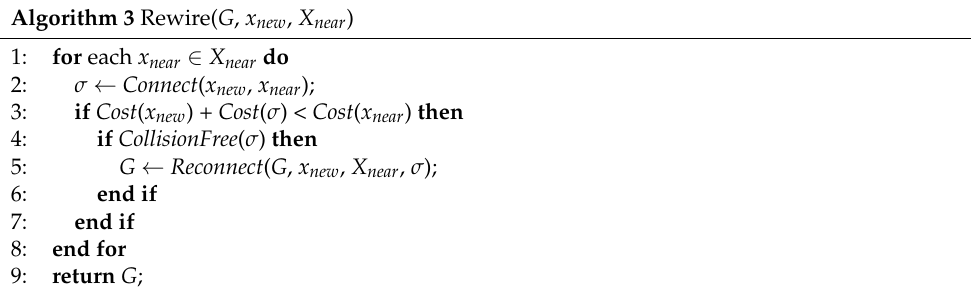
x new x new x nearest x